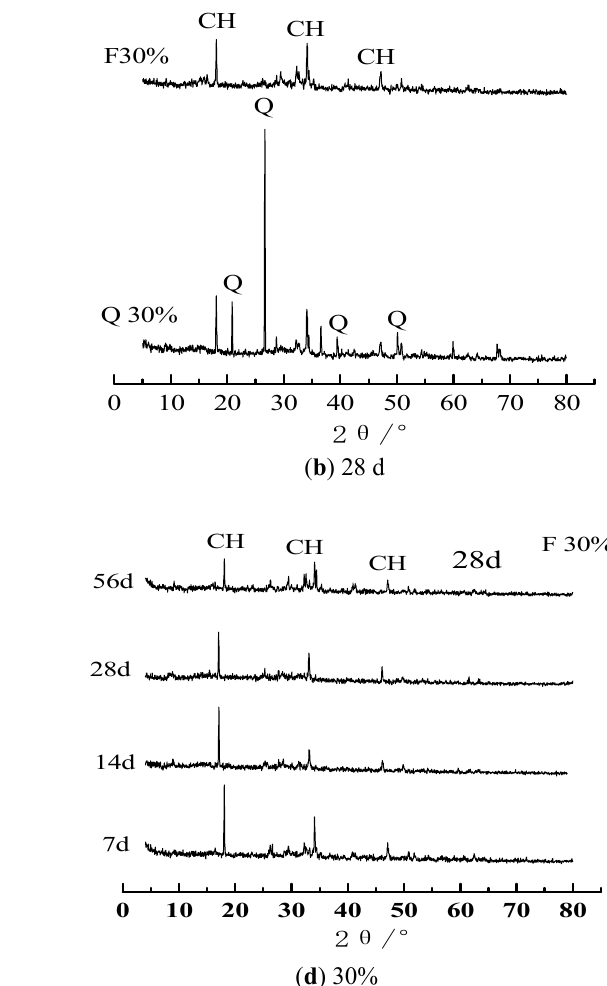
( h ) Figure 3. Development of the flexural ( a , c , e , g ) and compressive ( b , d , f , h ) strength of mortars under standard curing conditions. 3.3. Effect of Low-Calcium Fly Ash and Ground Quartz Powder on the Microstructure of Hard- ened Pastes In order to reveal the time-effect and the mechanism of action of low-calcium fly ash, the hardened cement paste was doped with different concentrations of low-calcium fly ash and quartz powder at a water/binder ratio of 0.45. Pastes were characterized by X-ray diffraction (XRD), scanning electron microscopy (SEM) and nitrogen adsorption. The symbols F 1 , Q and C represent hardened cement paste doped with first-class low-calcium